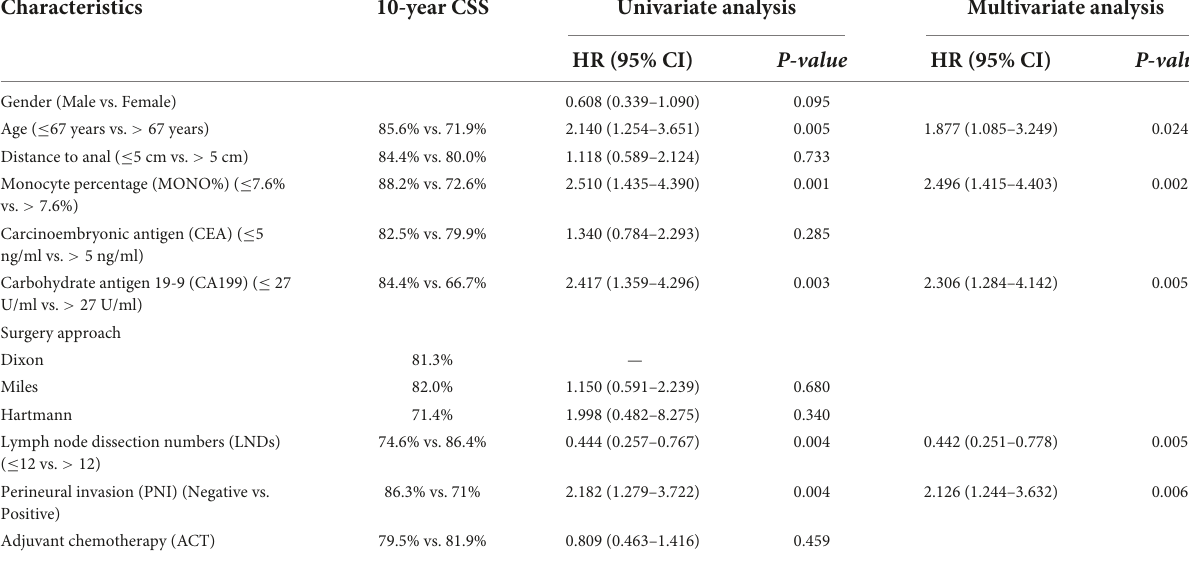
TABLE 2 Prognostic factors of 10-year CSS in univariate analysis and multivariate analysis. Characteristics 10-year CSS Univariate analysis Multivariate analysis HR (95% CI) P-value HR (95% CI)